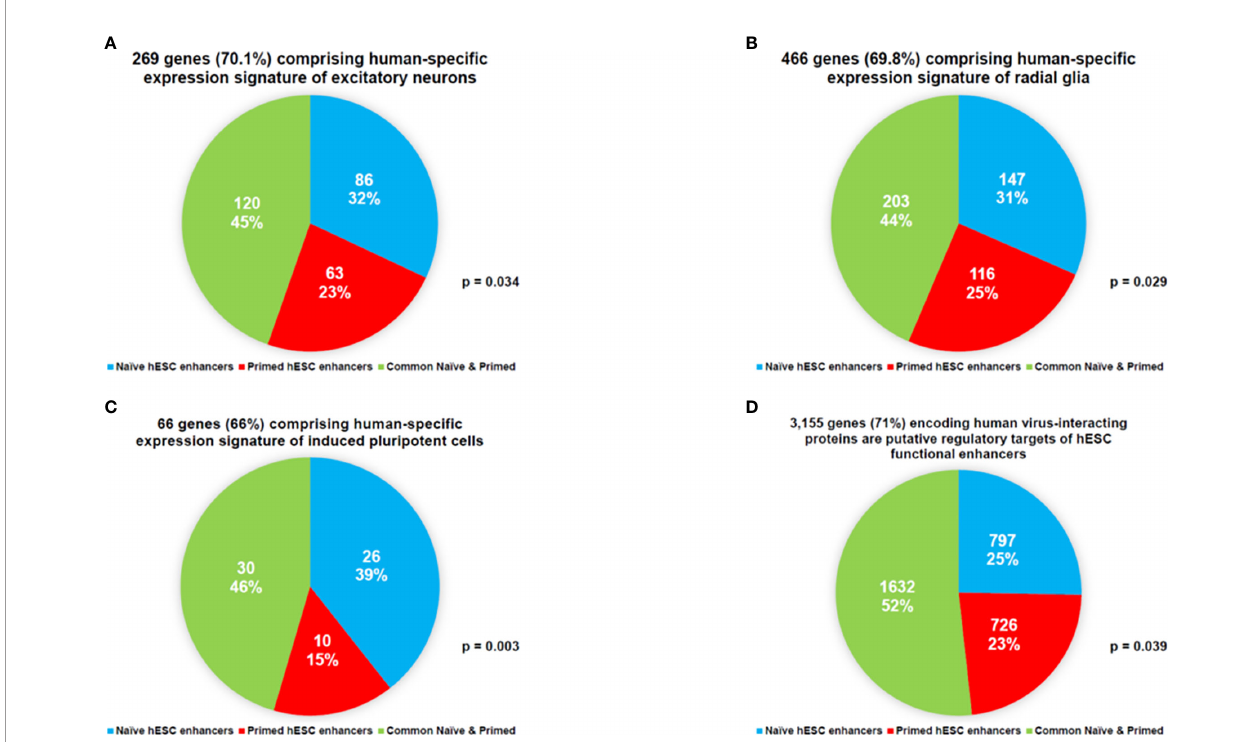
FIGURE 6 | Networks of genes regulated in Naïve and Primed hESC hESC by functionally-active enhancers are enriched for genes comprising human-speci fi c expression signatures of excitatory neurons (A) , radial glia (B) , induced pluripotent cells (C) , and human genes encoding a majority of virus-interacting proteins (D)